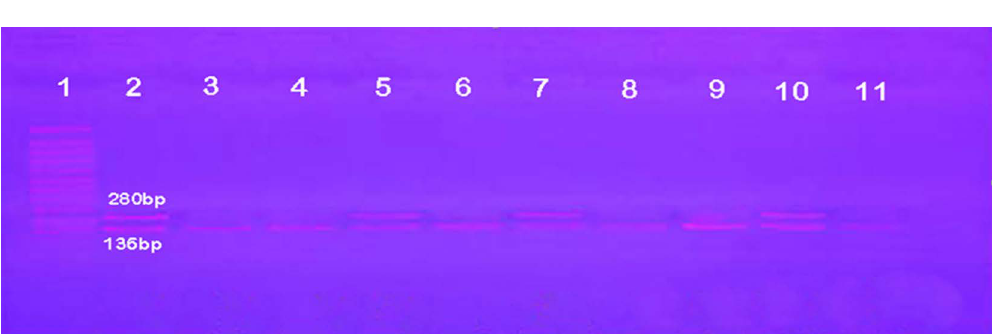
Fig. 2 . RFLP-PCR assay using restriction enzymes Sac II were used to detect the mutations in the present samples. mutant strains, indicate by single band(3,4,6,8,9,11), Non-Mutant strain indicate by double